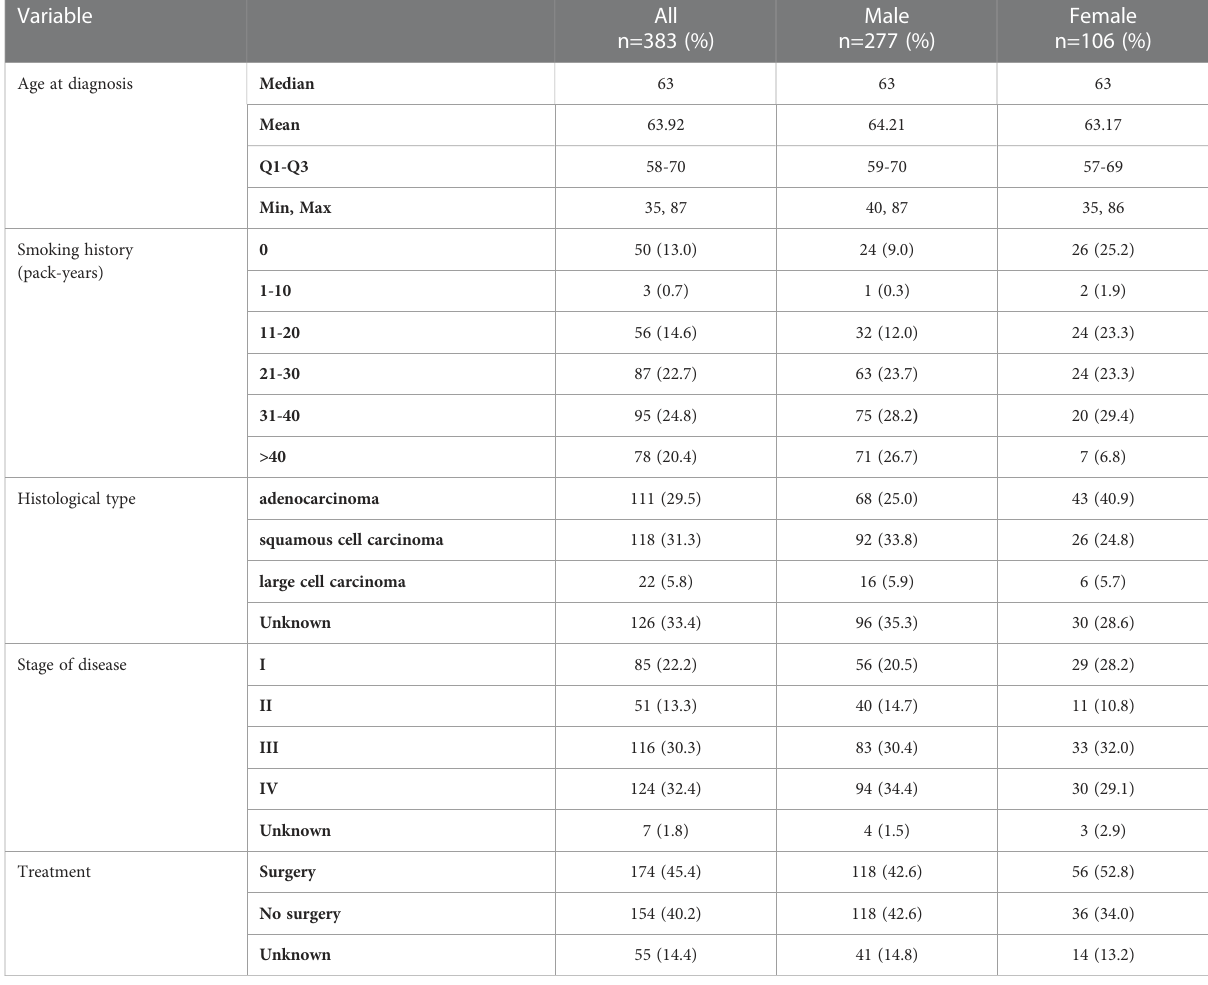
TABLE 1 Characteristics of NSCLC